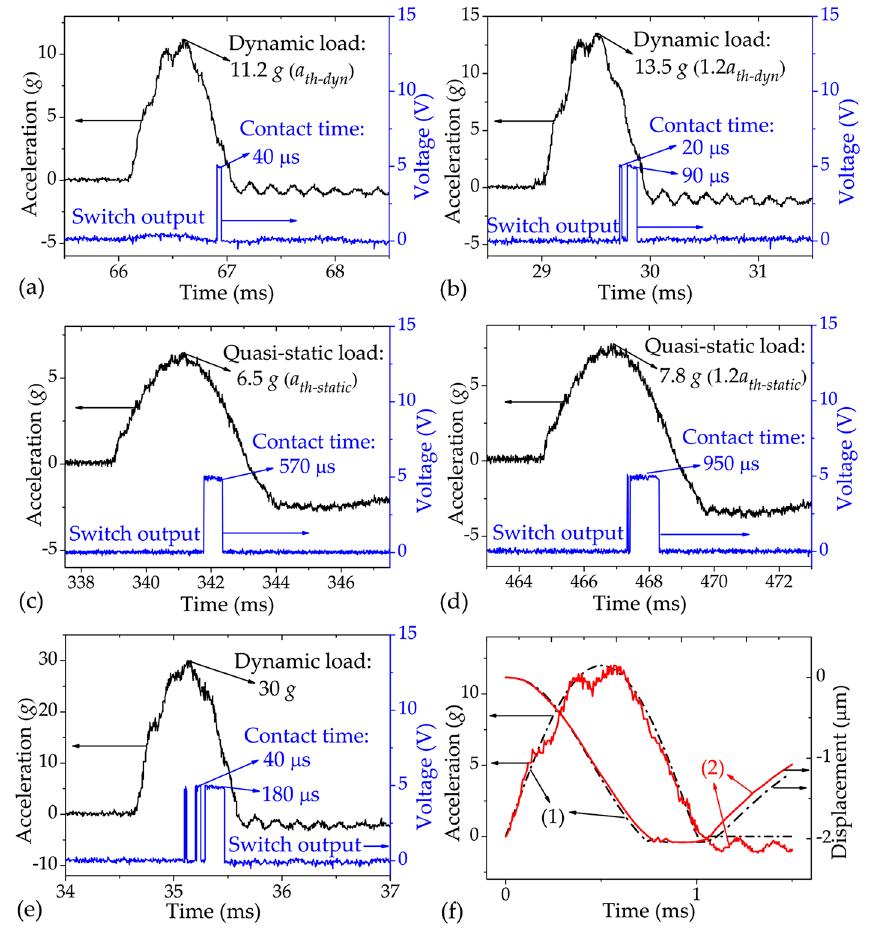
Figure 7. ( a – e ) Measured results of the fabricated switch under accelerations of ( a , b ) 11.2 g ( a th − dyn ) and 13.5 g (1.2 a th − dyn ) dynamic loads; ( c , d ) 6.5 g ( a th − static ) and 7.8 g (1.2 a th − static ) quasi-static loads; ( e ) 30 g dynamic load. ( f ) Simulation results of the displacement response of the switch under (1) the standard and (2) the practical acceleration loads of 12 g amplitude and 1 ms